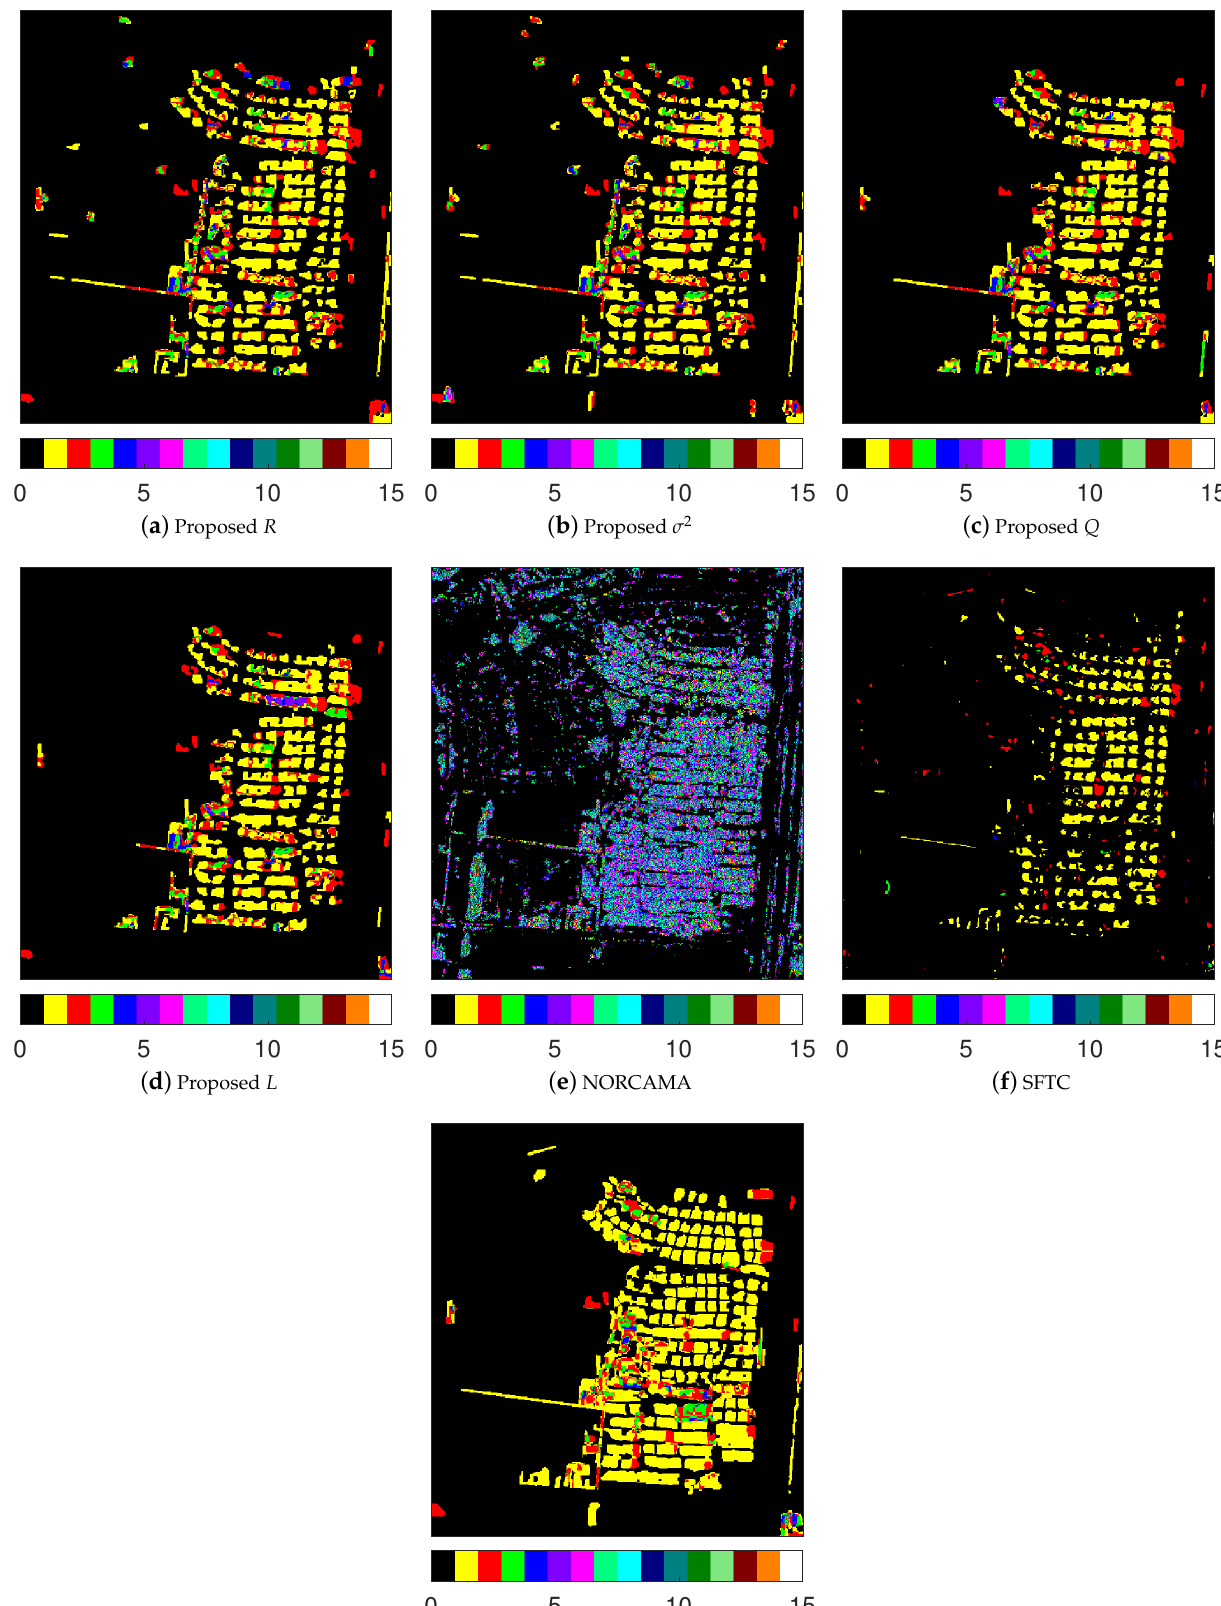
Figure 10. CFM of different methods using data